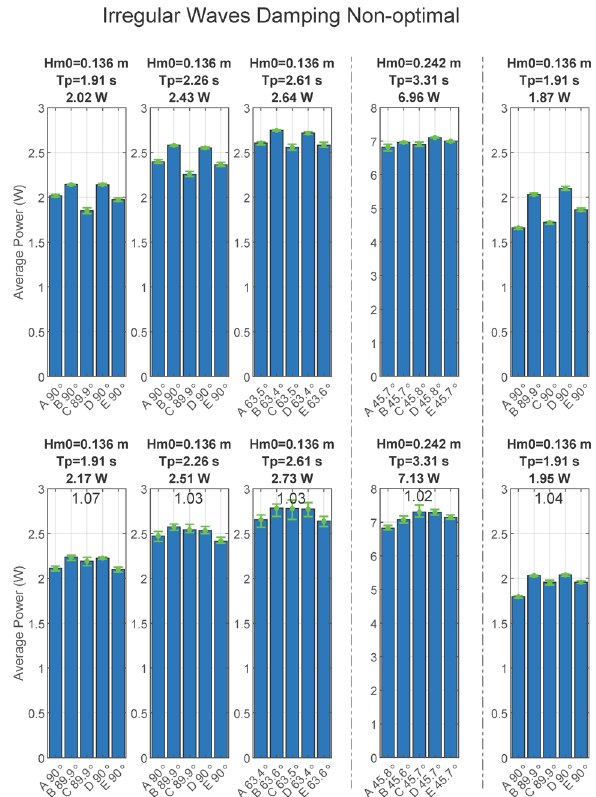
Fig. 9. Subplots of irregular wave average power for each OWC showing a different period wave input. Top row is non-optimized layout and bottom row is optimized layout. The last column shows a short-crested case with a spreading angle of 30 degrees. Bar graph represents average of three bridge positions average power. Error bars show minimum and maximum average power of the three bridge positions. Error bars indicate the repeatability in the measurements. The average of the five average powers for the array is shown in each title. The text number in the plot in the lower subplots represents the ratio of optimized over non-optimized layouts, often called the will be compared to linear frequency domain technique